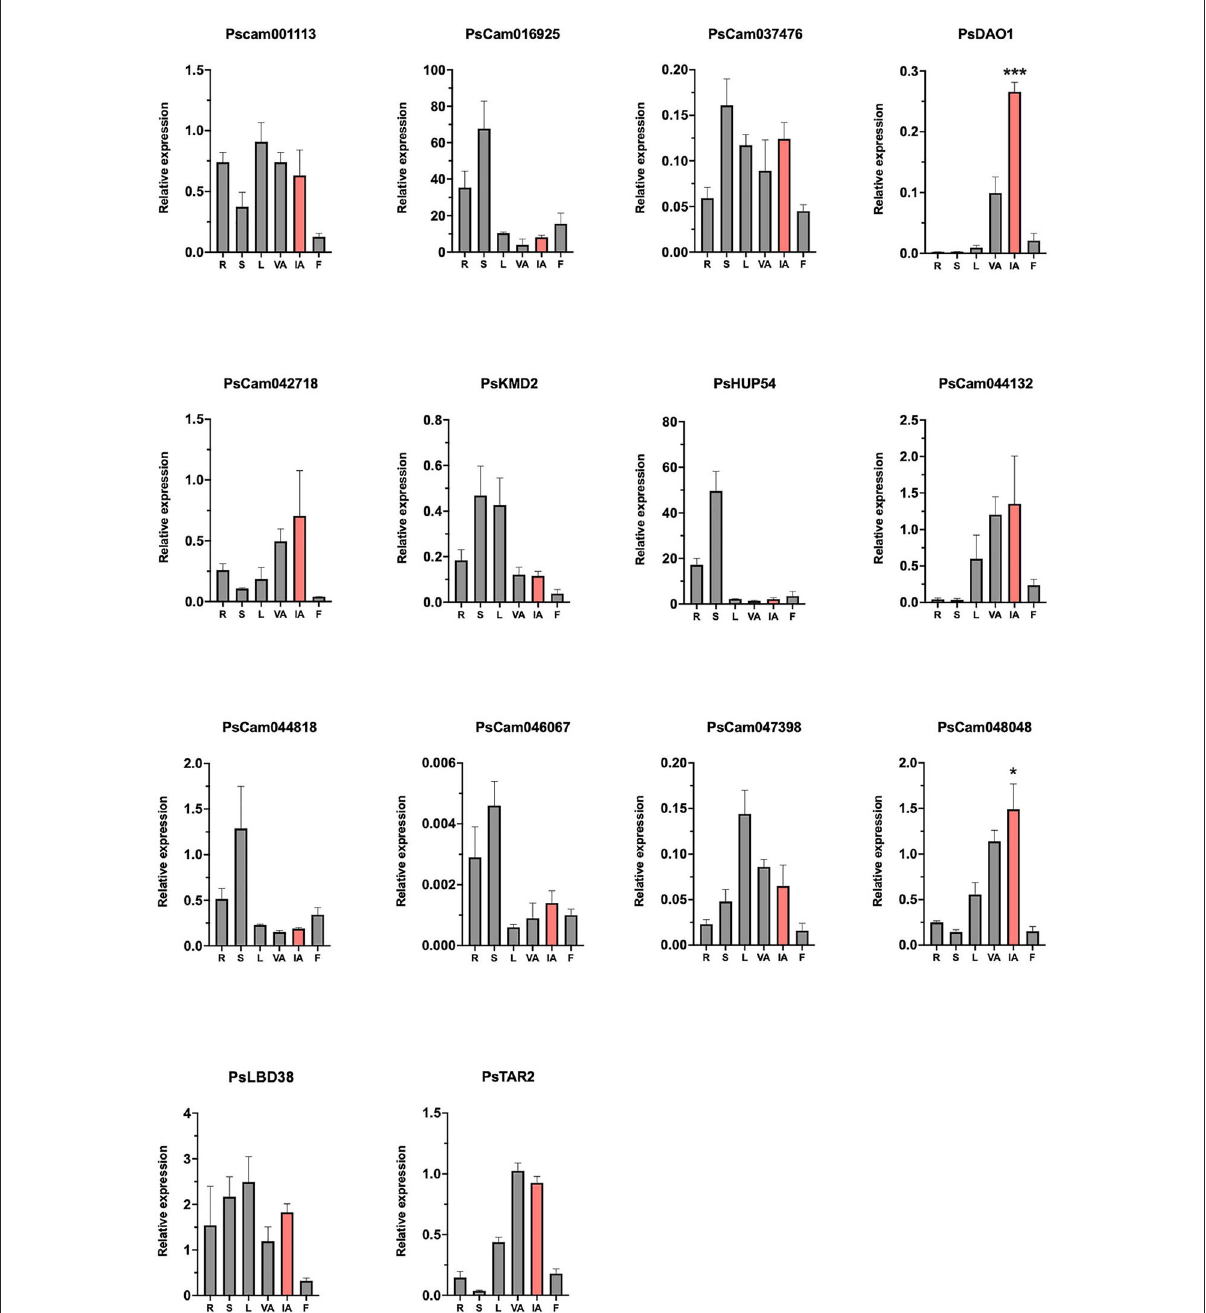
FIGURE5 Expression analysis by RT-qPCR of candidates for VEG1 target genes in different pea plant organs. Relative mRNA levels were determined by RT-qPCR. For the analysis, different samples were collected from wild-type plants: roots (R), shoots (S), leaves (L), vegetative apices (VA), inflorescence apices (IA - highlighted in red), and flowers (F). Roots, shoots, leaves, and vegetative apices were collected from 3-week-old plants, before the floral transition; the inflorescence apices (highlighted in red) were collected from ∼ 5-week-old plants after the floral transition had occurred, and flowers were collected at anthesis. Error bars correspond to standard